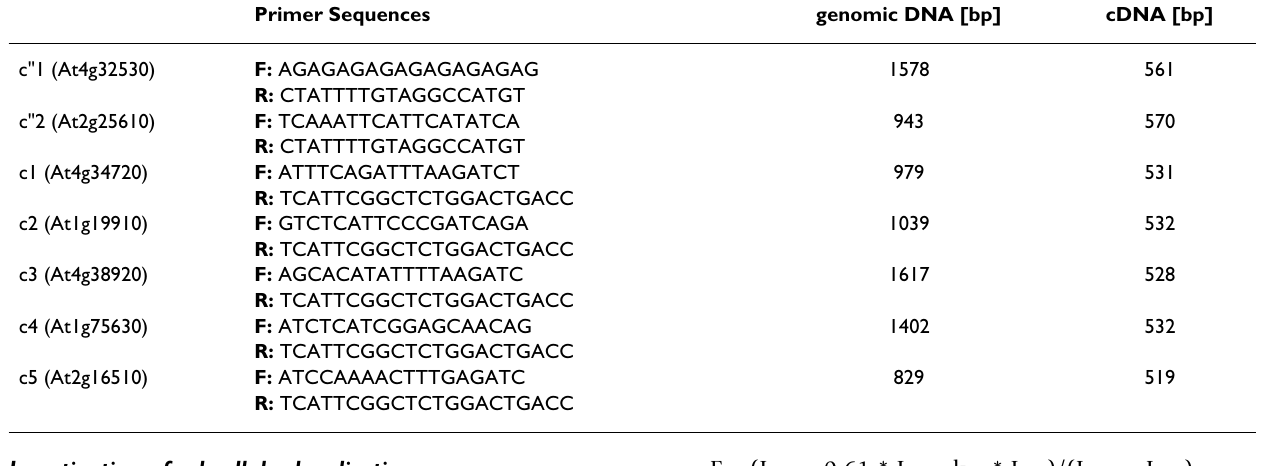
Table 1: Primer sequences and resulting product size of RT-PCR with genomic DNA and cDNA as template Primer